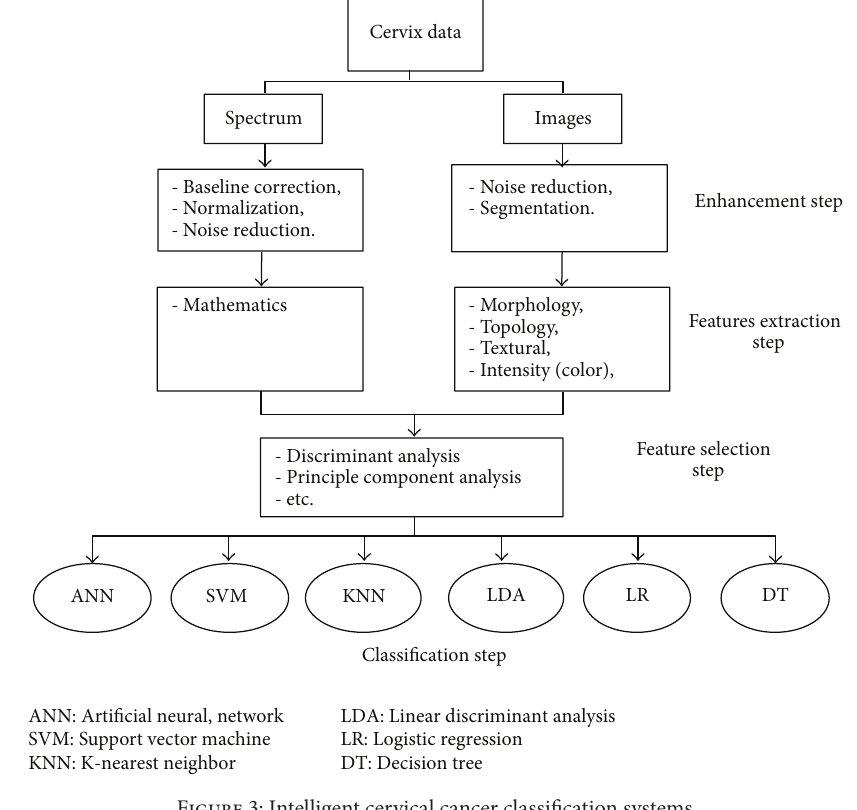
Figure 3: Intelligent cervical cancer classification systems. Table 2: Information about cervical screening